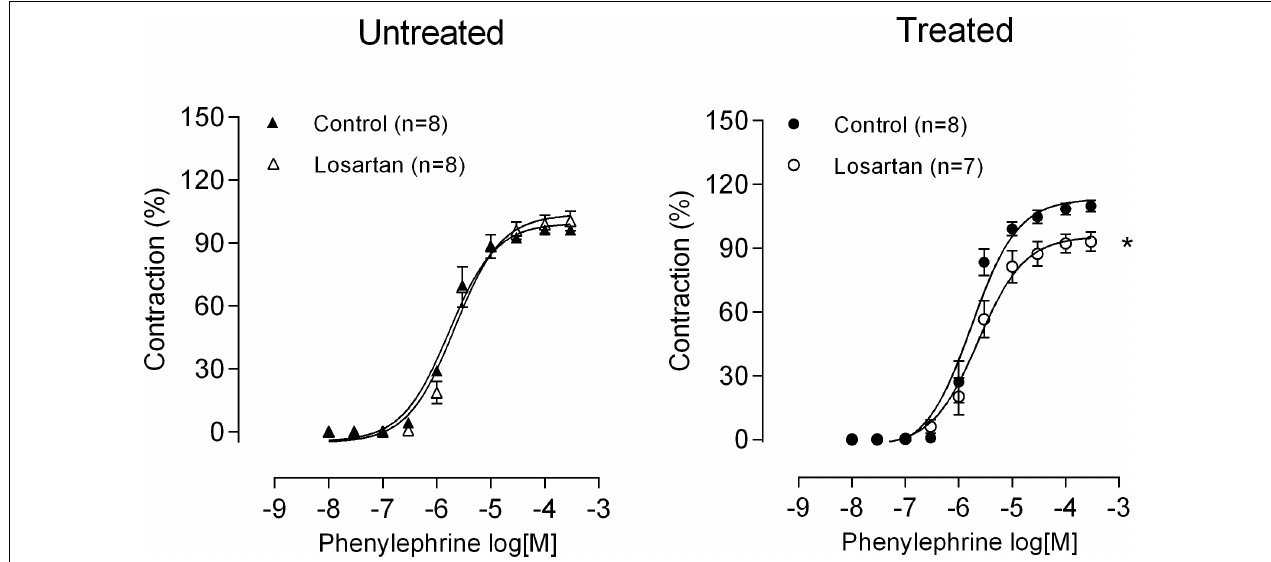
FIGURE 6 | Role of angiotensin II in the altered phenylephrine responses after lead treatment. The effect of the selective AT1antagonistlosartan on the concentration-response curve to phenylephrine in mesenteric rings from untreated and treated rats. * P < 0.05 versus control using two-way ANOVA and Bonferroni post hoc test. Data are expressed as the mean ± SEM. n denotes the number of animals used and is indicated in